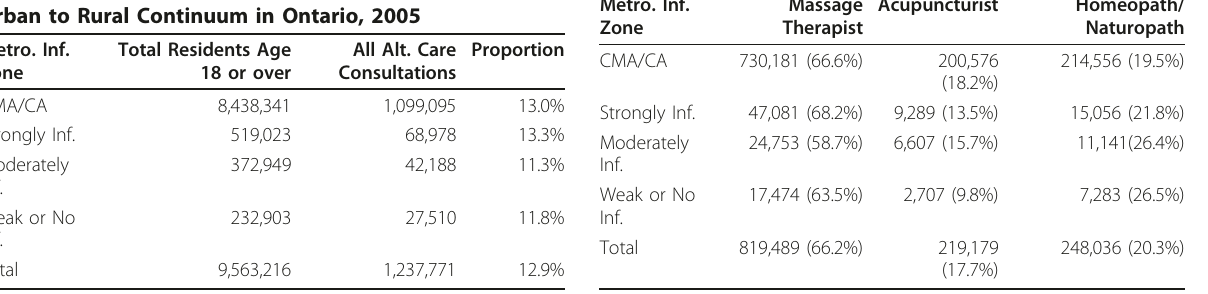
Table 3 Alternative Health Care Consultations Across the Urban to Rural Continuum in Ontario, 2005 Metro. Inf. Zone